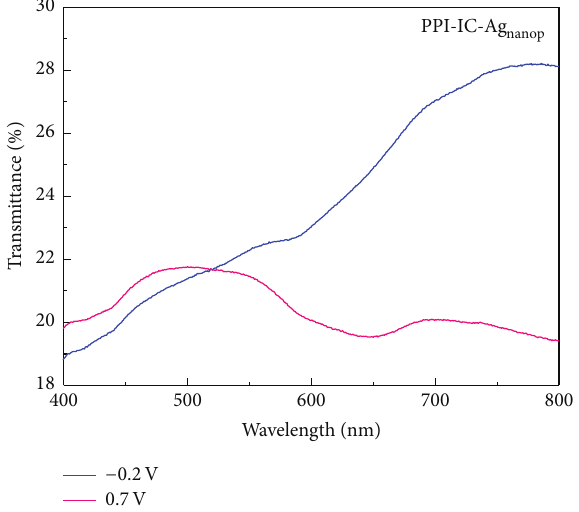
Figure 8: Optical contrast of PPy-IC-Ag nanop in 0.1 M LiClO 4 aqueous solution. The redox potentials ( − 0.2 V and 0.7 V) were applied for 90